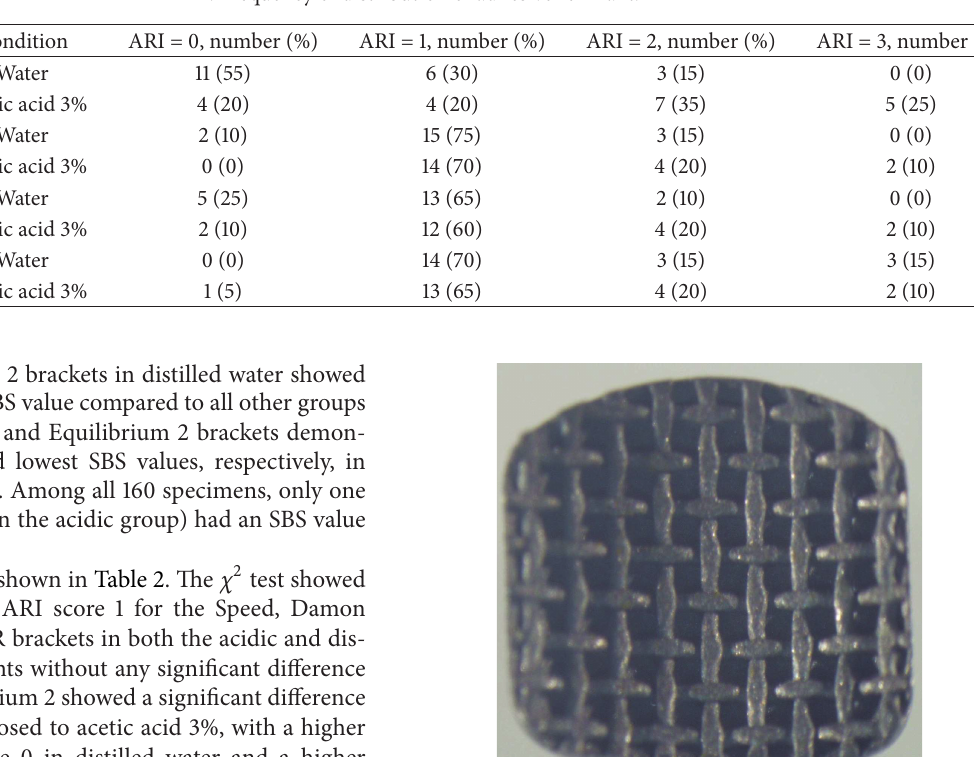
Table 2: Frequency of distribution of adhesive remnant.